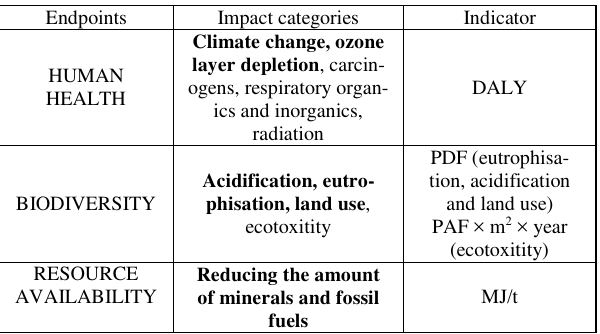
Table 1. Endpoints and assigned them impact categories and indicators in Eco-Indicator 99 method [10]